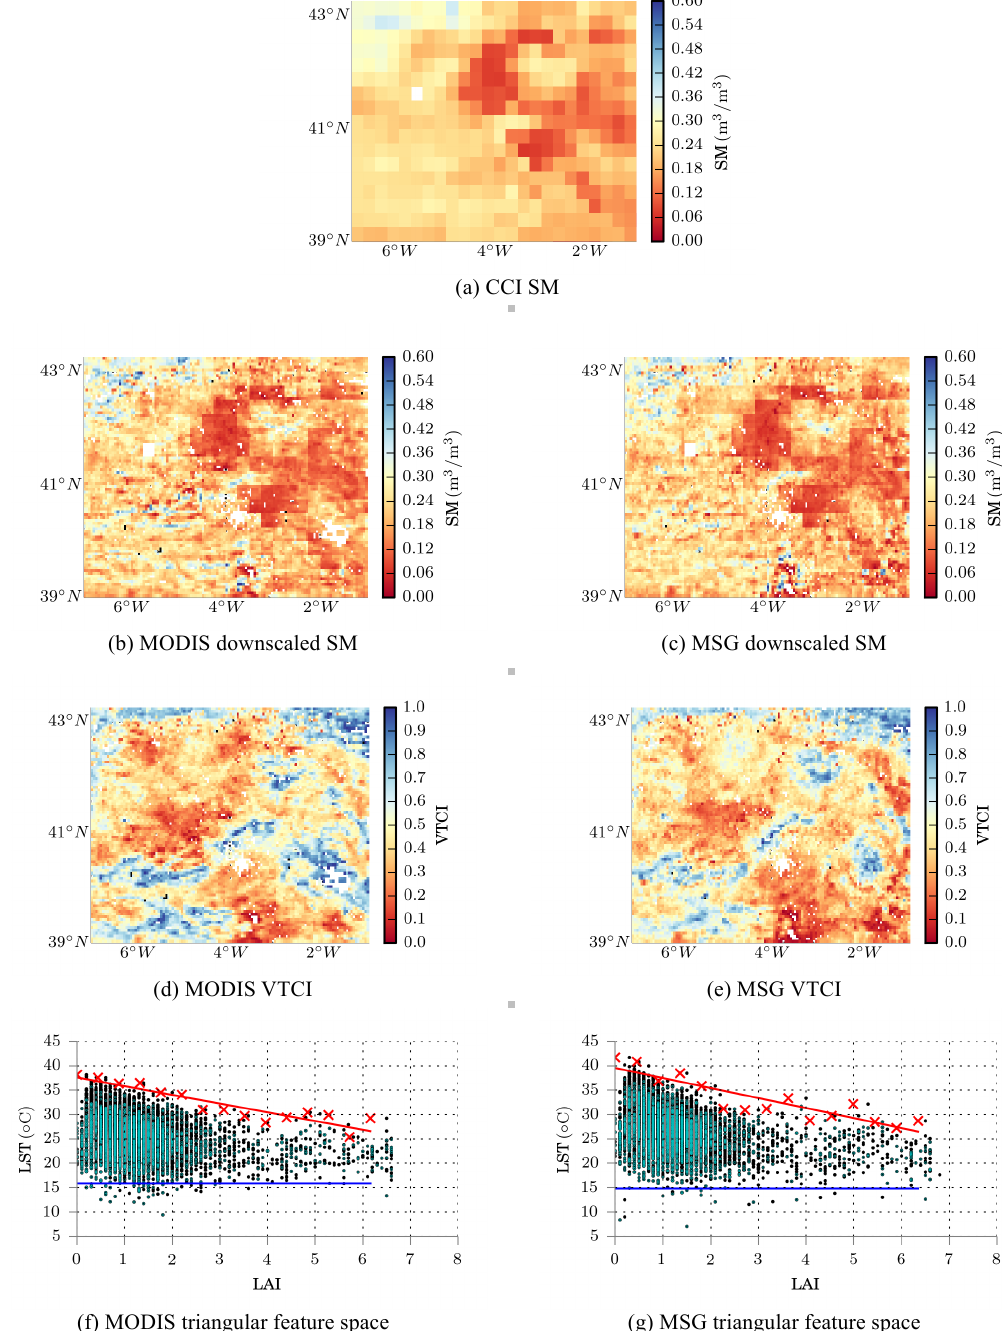
Figure 5. Spatial comparisons between coarse CCI soil moisture (a) and downscaled CCI soil moisture (b, c) based on MODIS and SEVIRI for 22 May 2010. The corresponding VTCI (d, e) and triangular/trapezoidal feature space (f, g) are also shown. The green points in the triangular feature space indicate the pixels with elevation 300m higher or lower than the average REMEDHUS